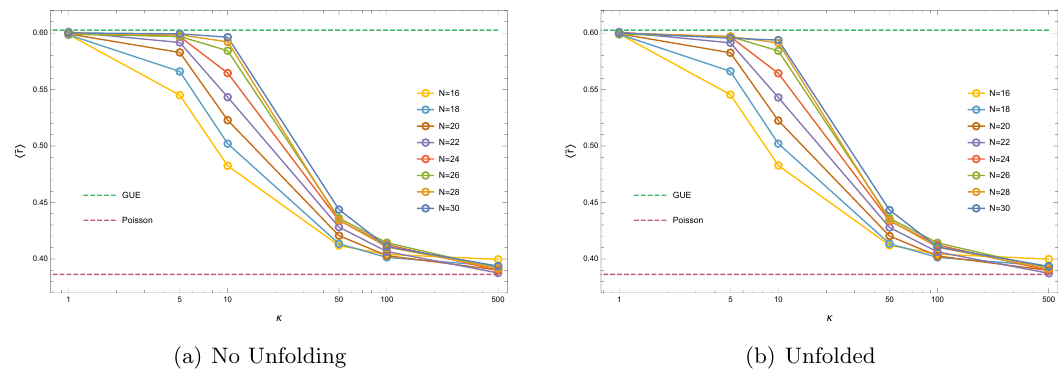
Figure 22 . The mean value of the ~ r -parameter for N = 16 ; 18 ; 20 ; 22 ; 24 ; 26 ; 28 ; 30 (1 5 (cid:20) 5 500) of (a) the spectrum without unfolding (b) the unfolded spectrum. The average is performed over M = 2000 ; 1000 ; 500 ; 300 ; 100 ; 100 ; 100 ; 100 ensembles,